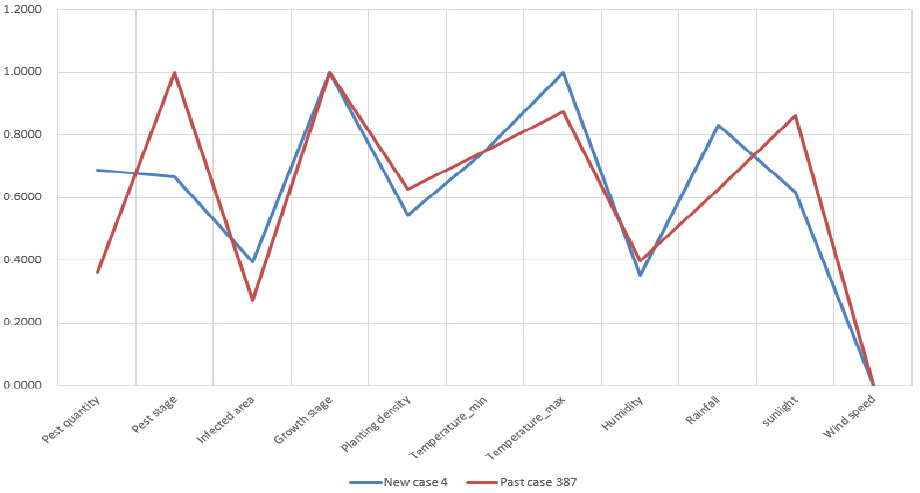
Figure A4. Attribute visualization of new case 4 and retrieved past case 387.